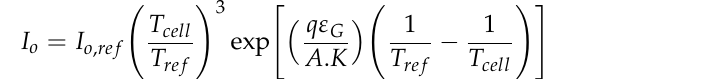
Figure 1. PV cell model.